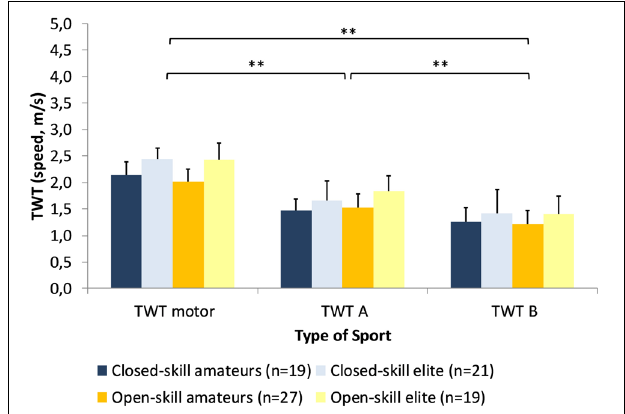
FIGURE 3 | Performance of the composite score on the Flanker Task as a function of expertise and type of sport.